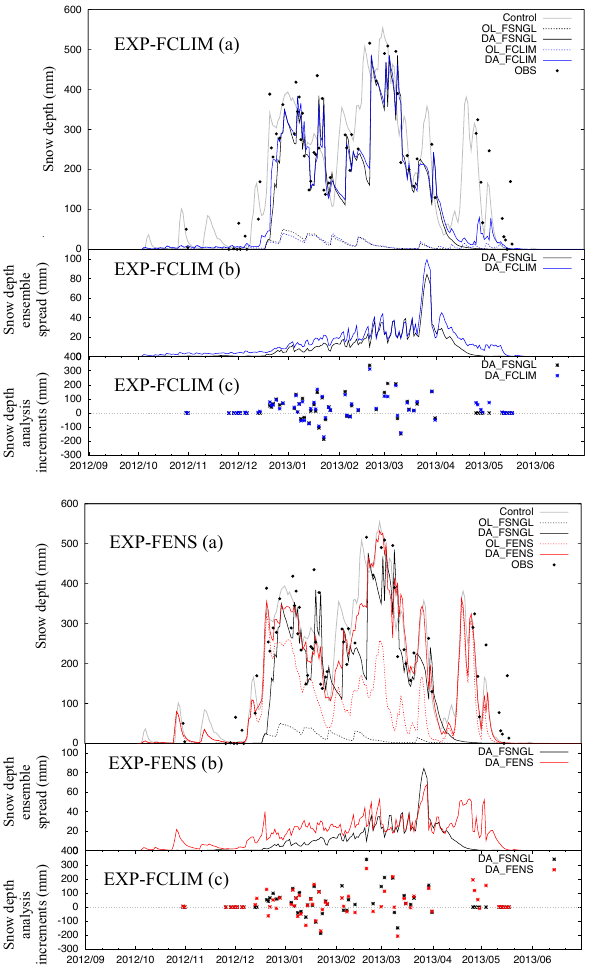
Figure 3. Similar to Fig. 2, with the time series of model simula- tions from EXP-FCLIM and EXP-FENS included (a) . The FCLIM experiments employ the use of a single forcing dataset and its cli- matology to force the ensemble and the FENS experiments employ the use of an ensemble of forcing datasets. The time series in (b) of the top and bottom figures compares the ensemble spread from the DA_FCLIM and DA_FENS integrations to the ensemble spread of DA_FSNGL integration, respectively. Panel (c) shows comparison of the analysis increments from DA